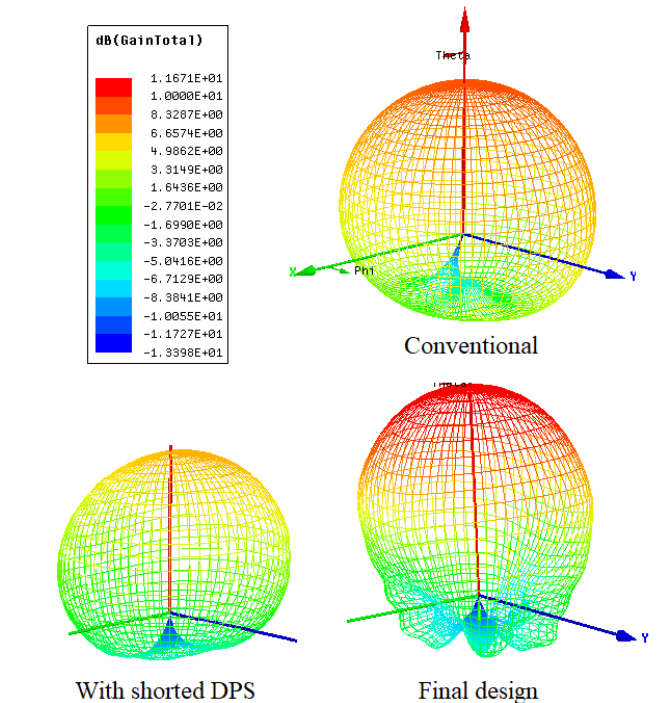
Figure 10. 3D radiation pattern of different